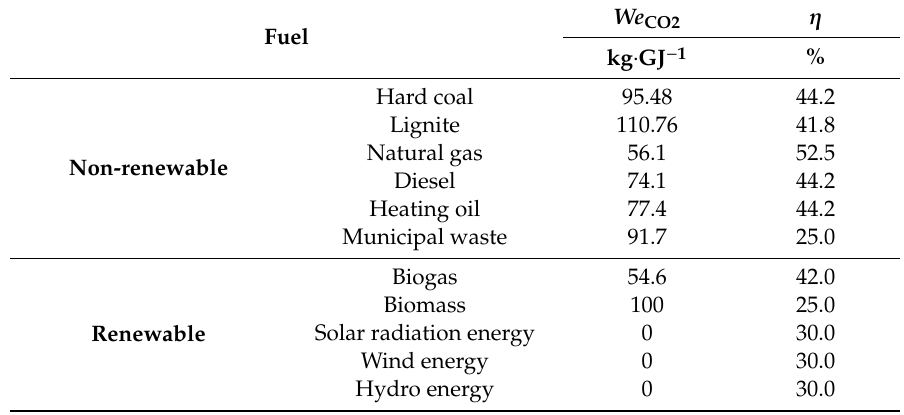
Table 3. We CO2 coe ffi cient and power plant e ffi ciency depending on the type of fuel combusted